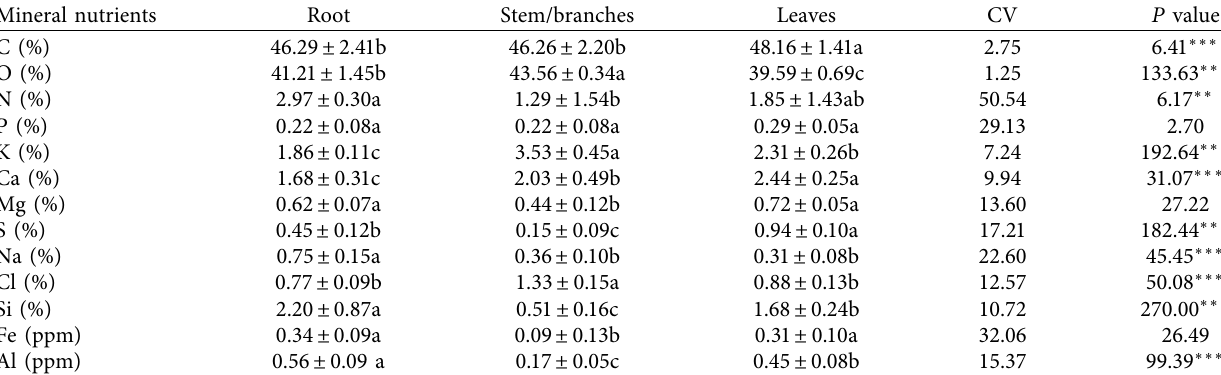
Table 3: Nutrient profile in the root, stem/branches, and leaves of cherry tomato. Mineral nutrients